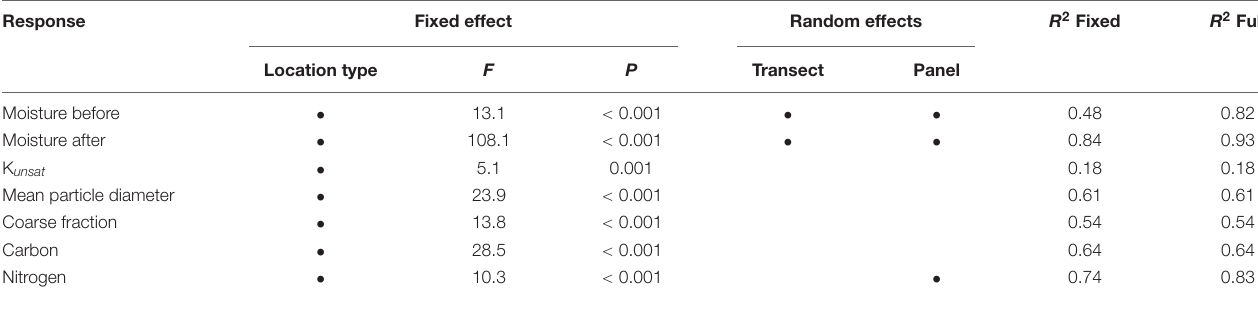
TABLE 1 | Statistical models and results for evaluations of whether soil properties differed by location